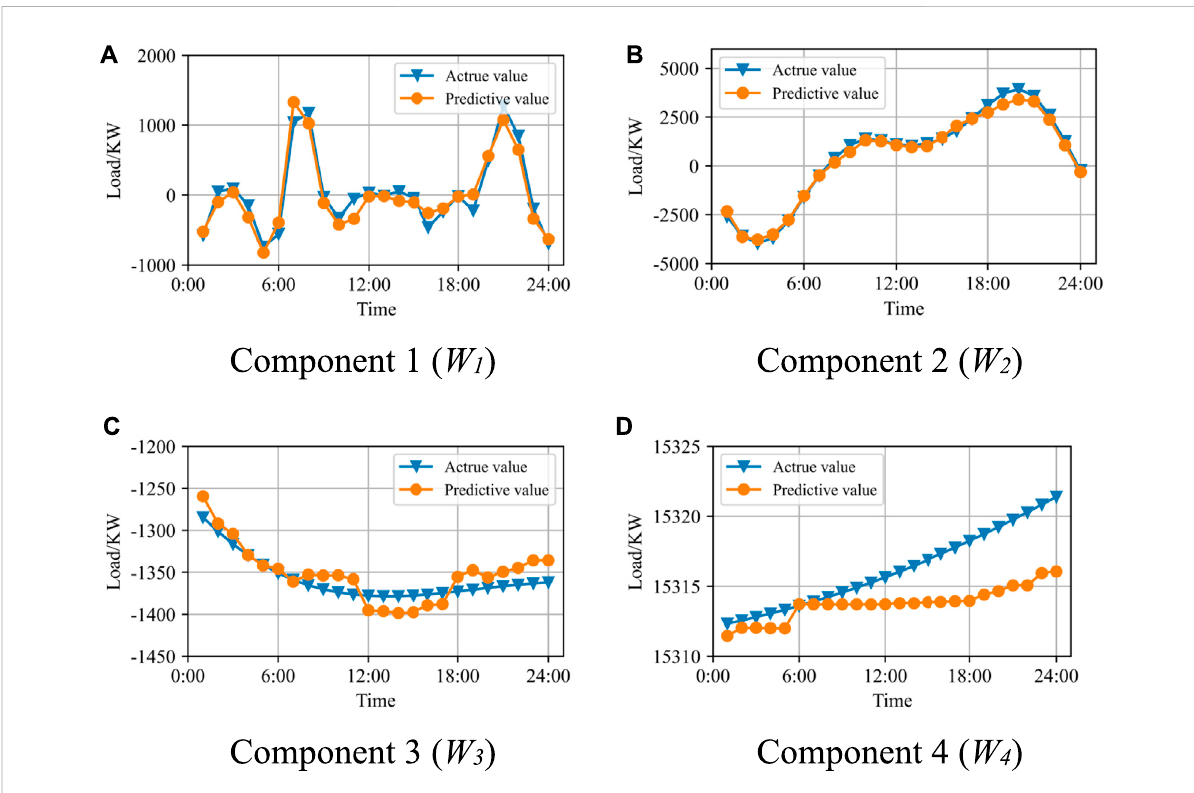
FIGURE 6 Forecasting performance of the proposed CEEMDAN-CatBoost-SATCN method with four components as examples including (A) Component 1, (B) Component 2, (C) Component 3, and (D) Component 4.